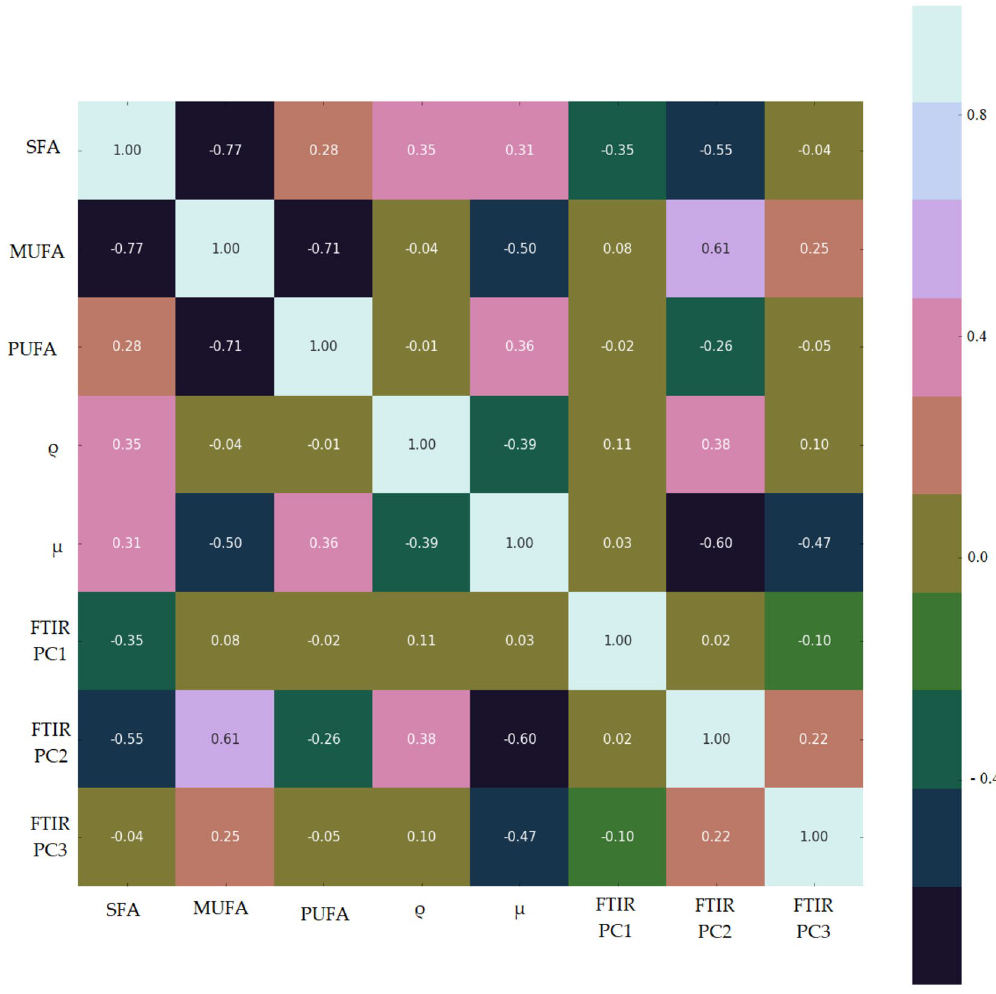
Table 2. Correlation coefficients between the relative concentration of SFA, MUFA, PUFA physical properties, and PC2, PC2, and PC3